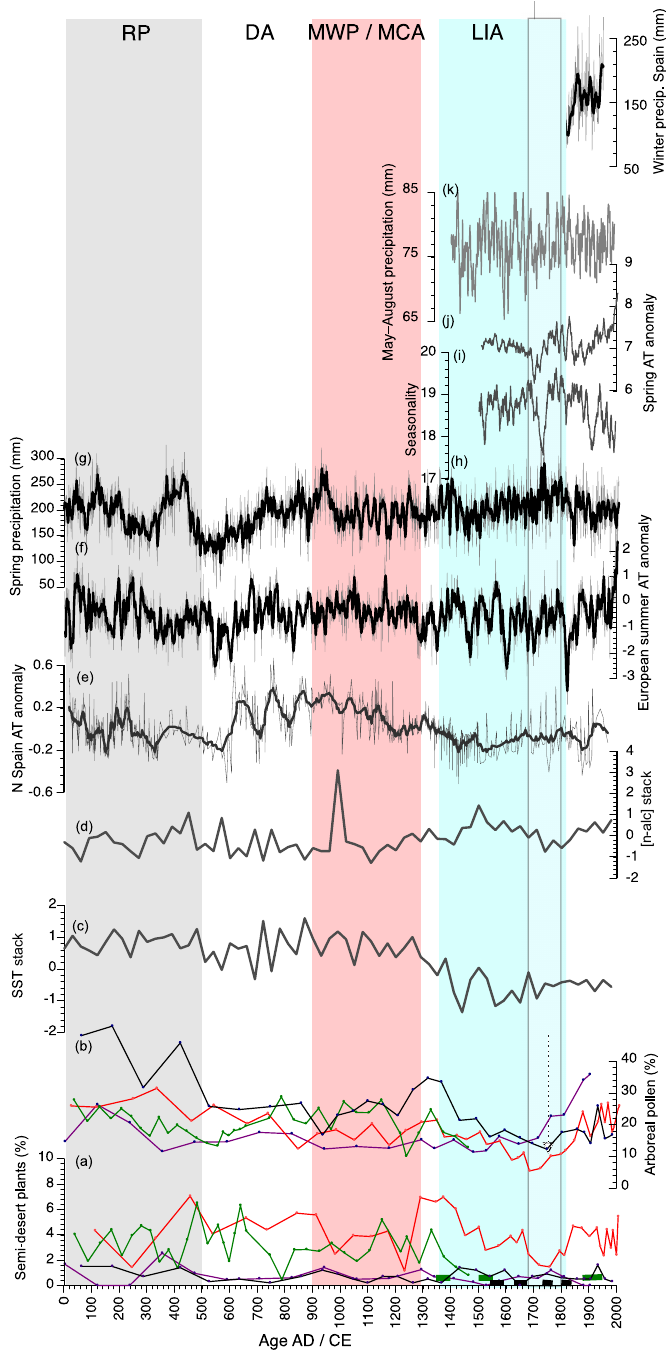
Figure 4. Variability in semi-desert plant percentages over the 2000 years in cores DIVA, Tagus, POPEI and Ria de Vigo (magenta, green, red and black, respectively) (Desprat et al., 2003) (a) ; arboreal pollen percent abundance (b) ; the SST stack (c) ; the [ n -alk] stack (d) ; northern Spain atmospheric temperature anomaly (Martín-Chivelet et al., 2011) (e) ; European spring–fall atmospheric temperature anomaly (Luterbacher et al., 2016) (f) ; spring precipitation central Europe (Büntgen et al., 2011) (g) ; European seasonality (h) ; spring AT (Luterbacher et al., 2004) (i) ; May–August precipitation (Touchan et al., 2005) (j) ; winter (DJFM) precipitation (Romero-Viana et al., 2011) (k) . Light gray band marks the RP; the pink band marks the MCA; the blue band marks the